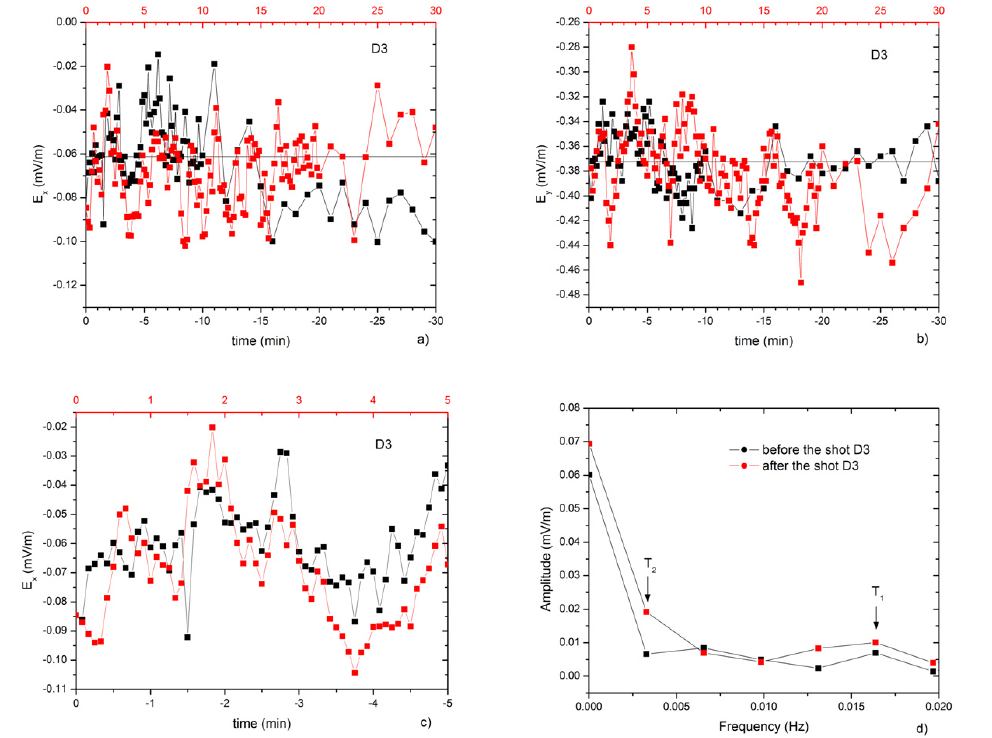
and E (in mV/m), observed along the AB and AC dipoles and related to the shot in D3, are Figure 5. Natural electric field components, E x y shown respectively in (a) and (b). (c) Time series of the E component registered with the short step (5s) 5 min before and 5 min after the x shot. Black symbols are used for data measured before the shot, while red symbols are used for data registered after the shot. The zero time of both the black and red scales corresponds to the shot time. The black continuous line represents the average value of the field compo- nent before the shot. (d) FFT of the signal shown in